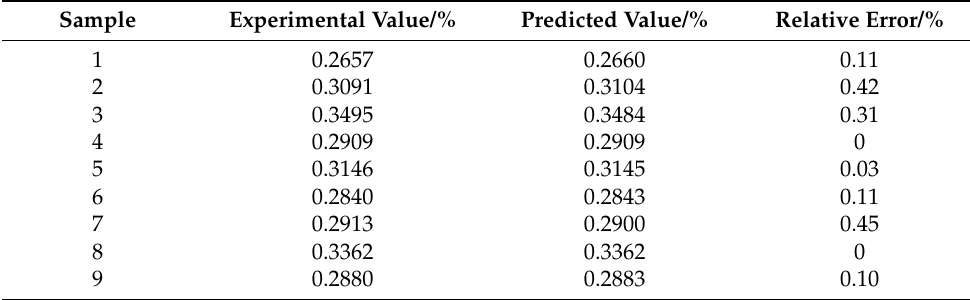
Table 5. Comparison of experimental data with predicted values by BP